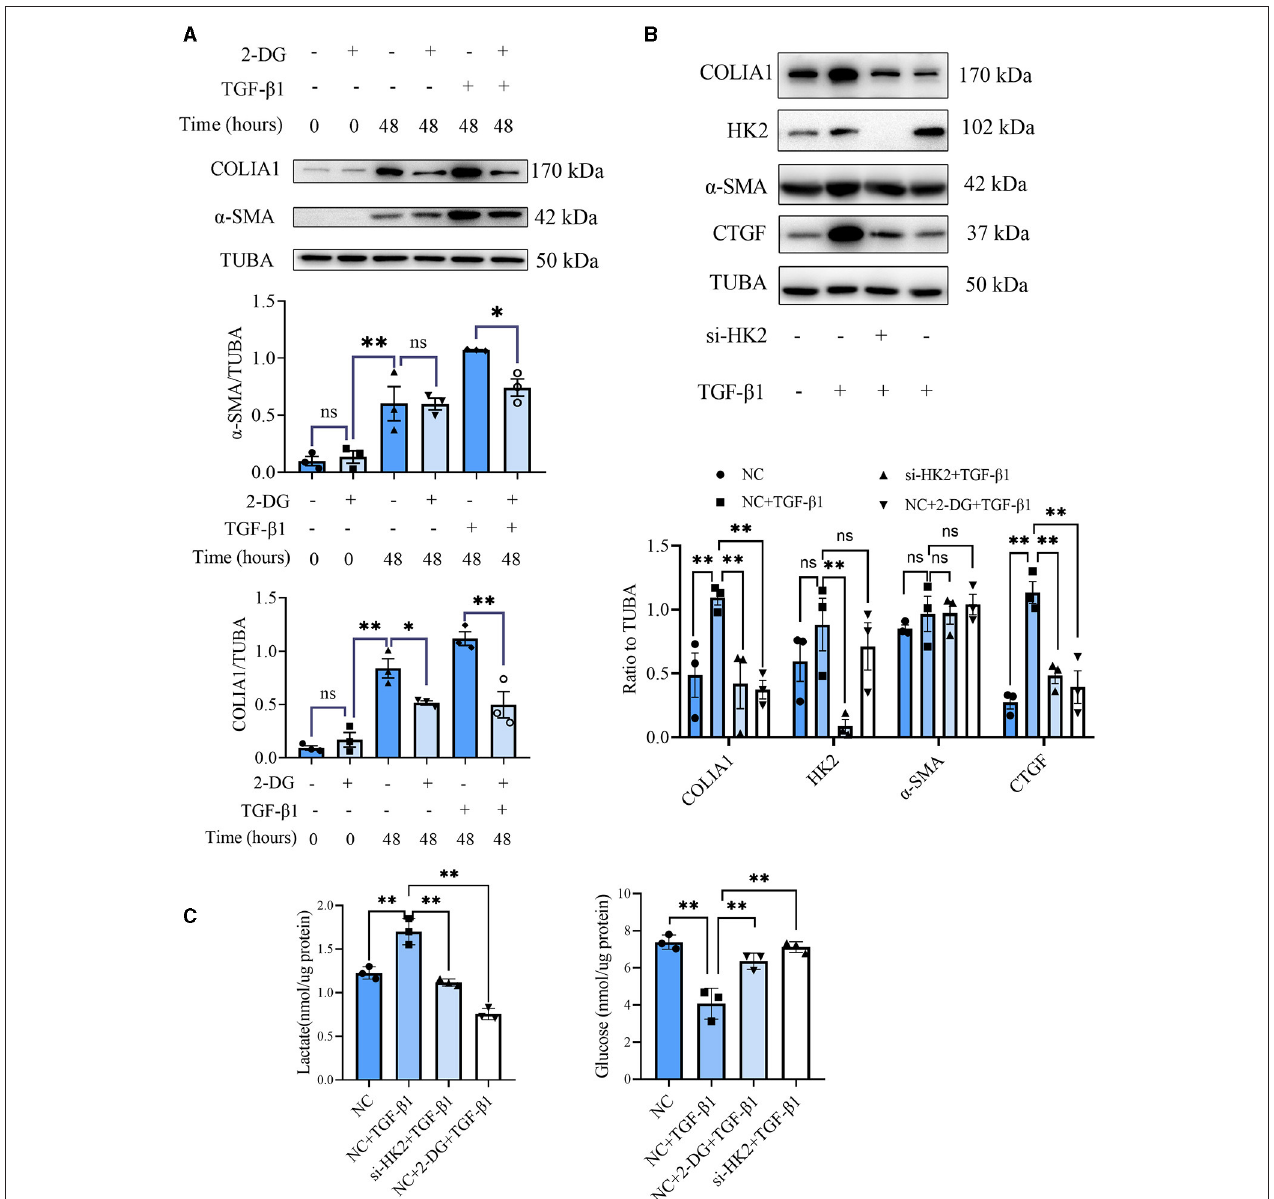
FIGURE 4 | Glycolysis inhibition could reverse the fibroblasts activation in vitro . (A) Western blot of 2-DG effect on TGF- β 1-induced human CF activation. (B) Western blot of 2-DG effect on TGF- β 1-induced mouse CF activation. (C) Lactate and glucose measurement in the culture medium from cells. The representative image and the statistical analysis were shown, respectively. COLIA1, type I collagen; α -SMA, alpha smooth muscle actin; CTGF, connective tissue growth factor; TUBA, α -tubulin; 2-DG, 2- deoxy-D-glucose; TGF- β 1, transforming growth factor- β 1; NC, negative control; si-HK2, siRNA against HK2; n = 3, * P < 0.05; ** P < 0.01; ns, no significance. Scale bar = 100 µ